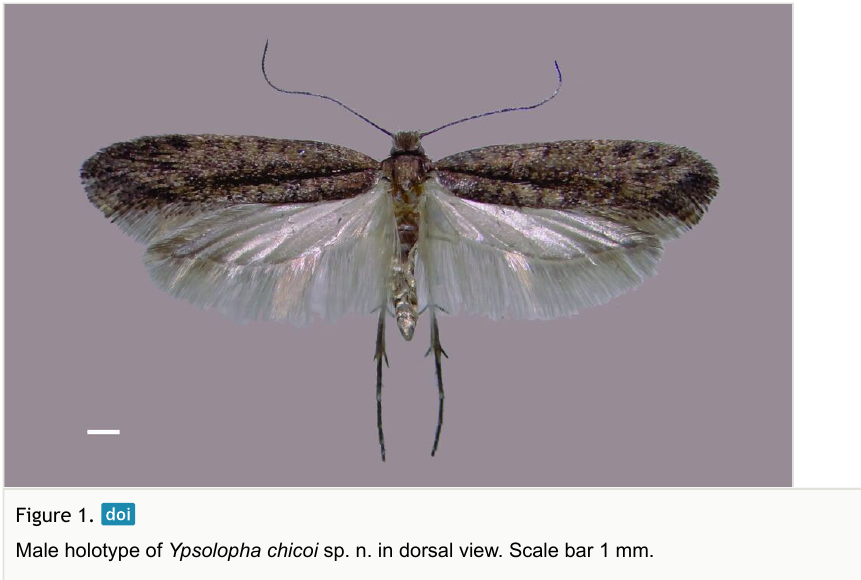
Figure 1. Male holotype of Ypsolopha chicoi sp. n. in dorsal view. Scale bar 1 Abdomen. Mostly yellowish-white with a few greyish-brown scattered scales. Male tergum VIII triangular, with a pair of sclerotised posterior projections encircling the base of pleural lobes; sternum VIII mostly membranous, with a pair of coremata. Male genitalia (Fig. 2) Tegumen bilobed, anterior margin deeply excavated. Socius digitate, narrowing apically, hair-like scales on the medial third. Gnathos Y-shaped; ventral arm widened, flattened, coarse, round apex, length about half the dorsal arms. Saccus cylindrical, length about 1.5 times the socius, round apex. Anellus with two narrow longitudinal sclerotised stripes separated by membranous area. Valva ovate; costal margin slightly rounded, with a slightly differentiated knob on the apex; distal margin broadly rounded. Phallus sub-cylindrical, broadly ventrally curved at middle, apex with a narrow ventral cleft, coecum about a fourth the phallus length; vesica with two small spine-shaped cornuti, length of the longest about twice the width of the distal third of the phallus. Female. Similar to male in size and maculation.